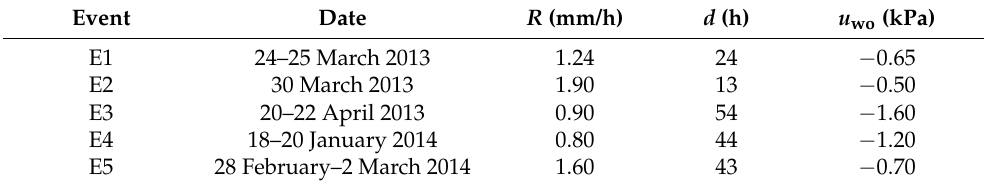
Table 1. Date, rainfall intensity, duration, and initial pore pressure for the rain events considered in the present study (data drawn from [43]).